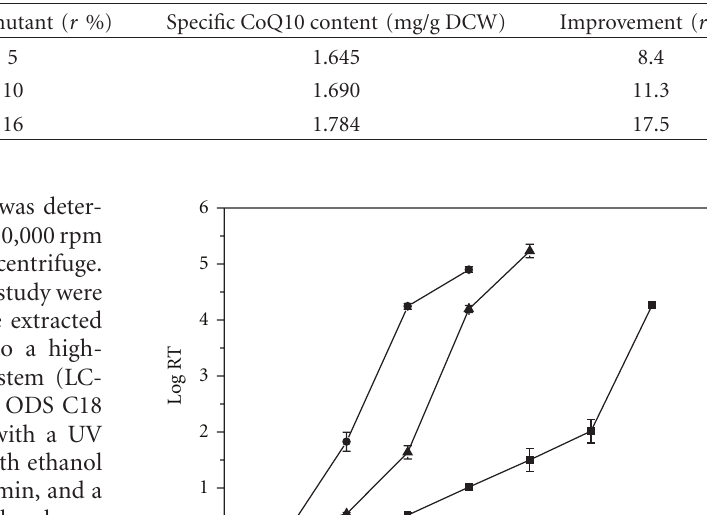
Table 1: HHP treatments on mutation of A. tumefaciens .